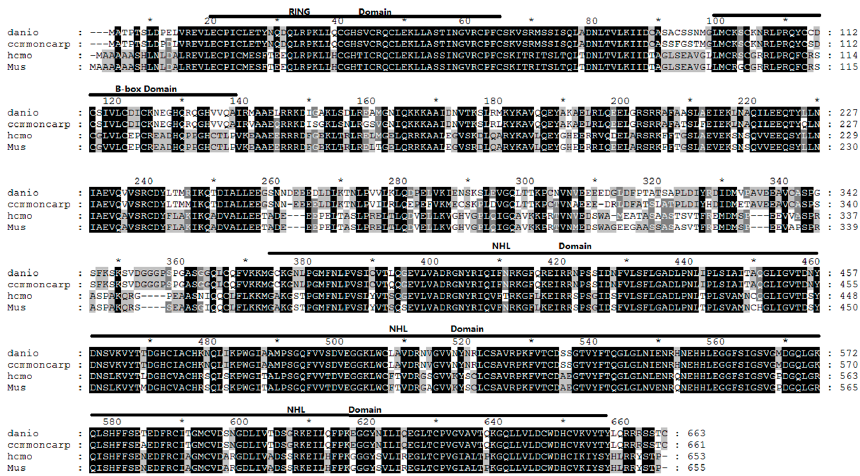
Figure 1. Multiple alignments of tripartite motif-containing protein 32 (TRIM32) amino acid sequences of Danio rerio , common carp, human, and mice. The amino acid sequence of common carp TRIM32 was predicted from the nucleotide sequence. The high conservation RING (AA 17 –AA 62 ), B-box (AA 96 –AA 136 ) and NHL (AA 369 –AA 651 ) functional domain of TRIM32 across different species were marked with solid bold line; * means the middle number of the two numbers nearby it.